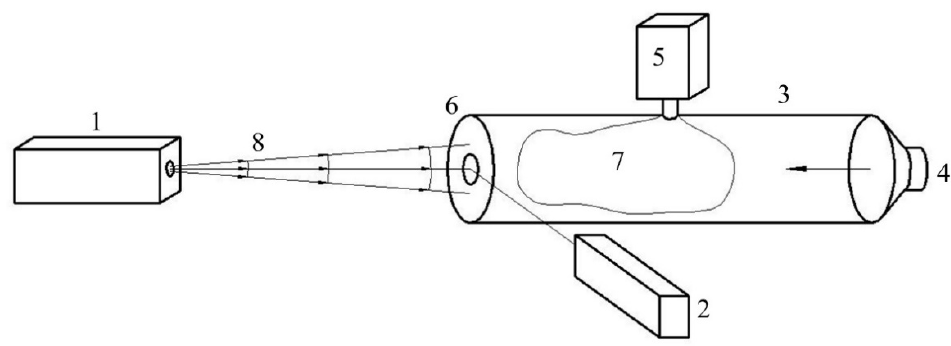
Figure 7. The scheme of the experimental setup: 1—laser, 2—high-speed camera, 3—impedance tube, 4—source of sound, 5—vapor generator, 6—partition with an orifice, 7—vapor azeotropic mixture, 8—laser “knife”.